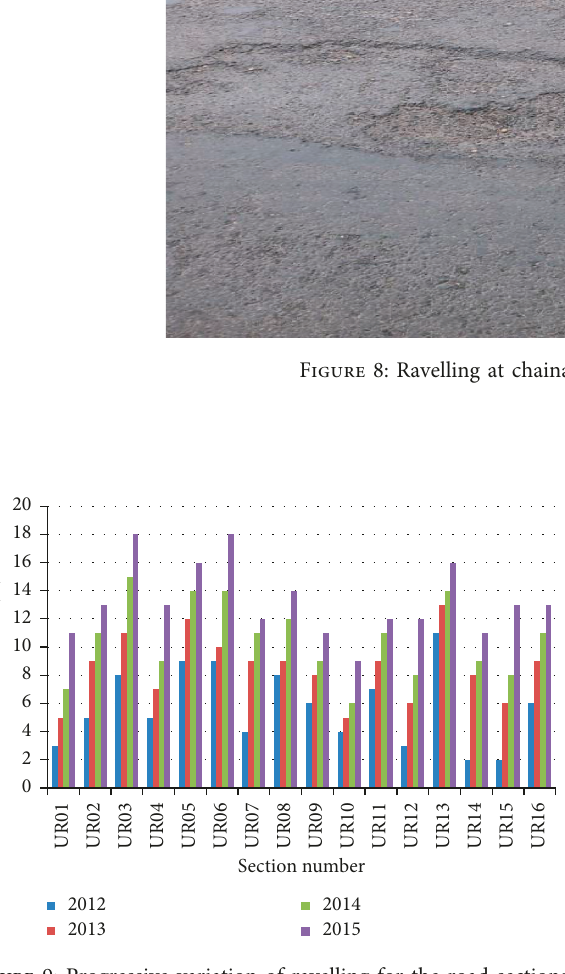
Figure 9: Progressive variation of ravelling for the road sections UR01 to